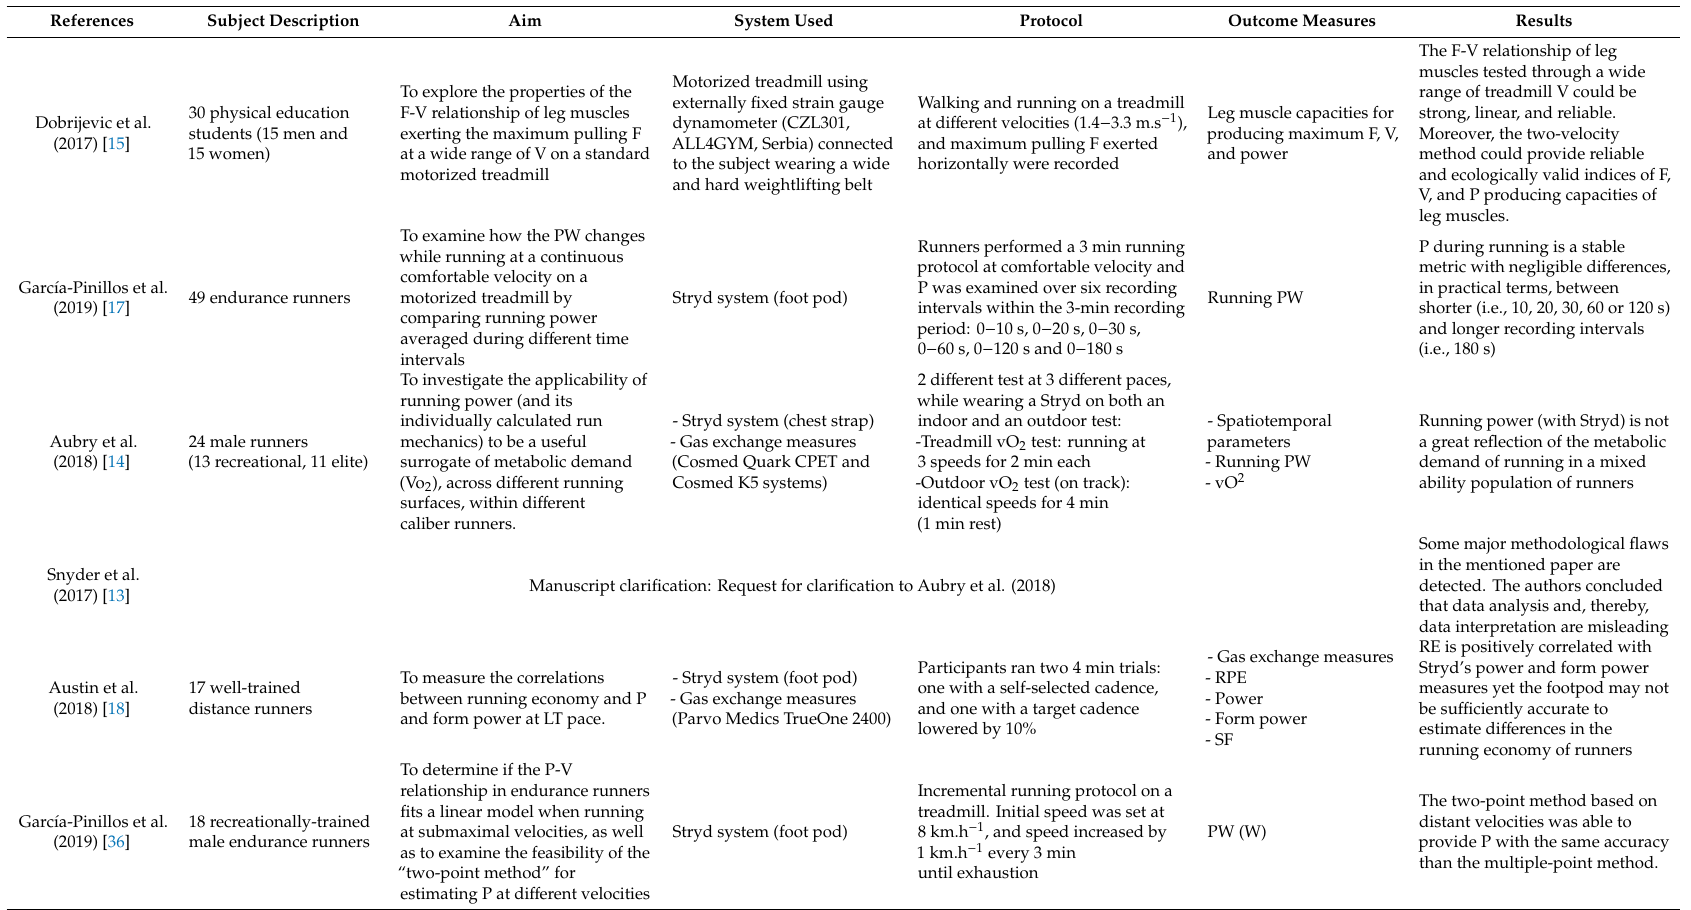
Table 1. Studies ( n = 12) involving the use of wearable sensors with the capacity of measuring power during running